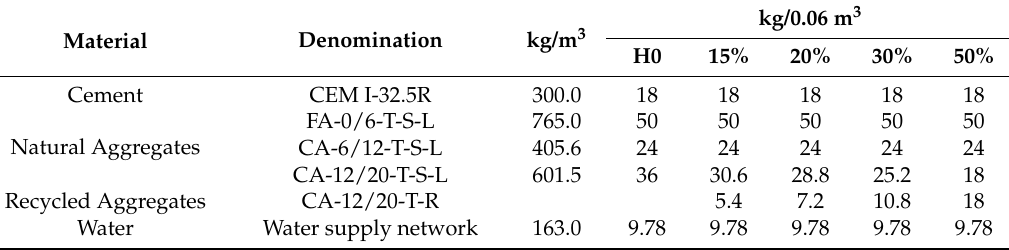
Table 2. Concrete mix design conducted in